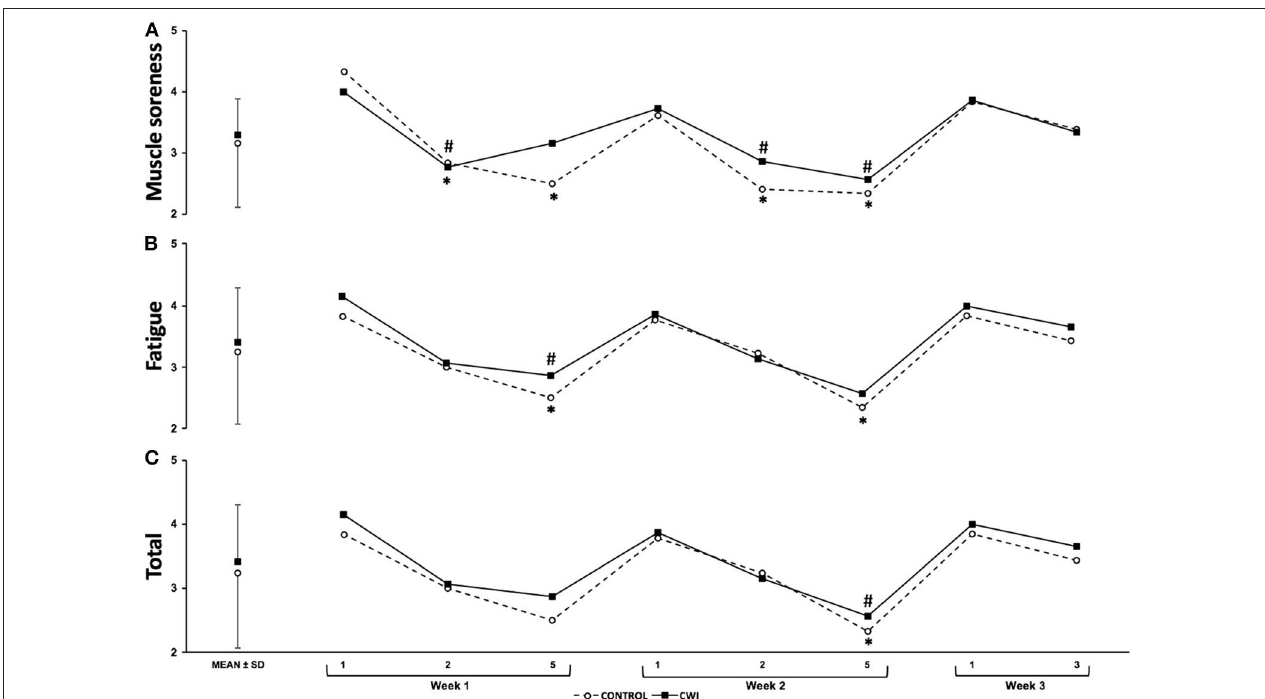
FIGURE 4 | Mean ± SD wellness scores at different time points for CWI and Control groups. (A) Soreness; (B) Fatigue; (C) Total *Significant difference ( p < 0.05) from baseline in the Control group. # Significant difference ( p < 0.05) from baseline in the CWI group.